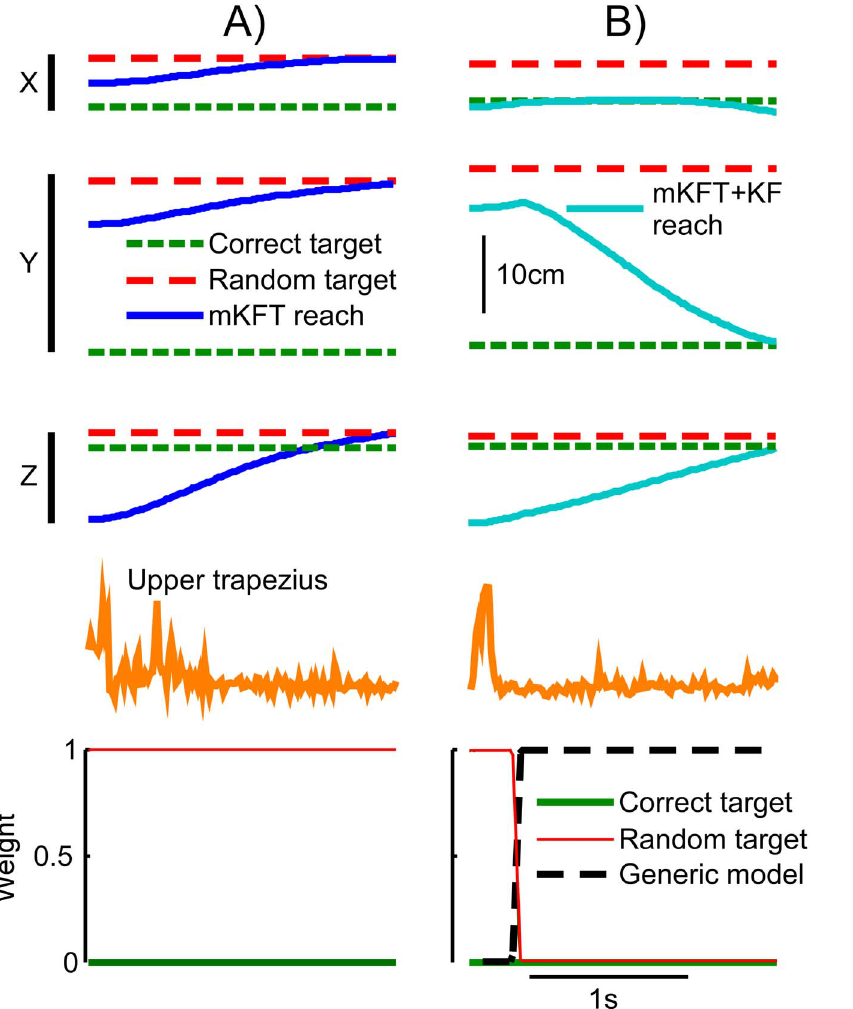
Figure 6. Example reaches with inaccurate target information, where the random target was assigned a prior probability of 1. 3- dimensional robot endpoint position, RMS feature of EMG windows, and mixture weights with A) mKFT and B) mKFT + KF, incorporating the generic model.